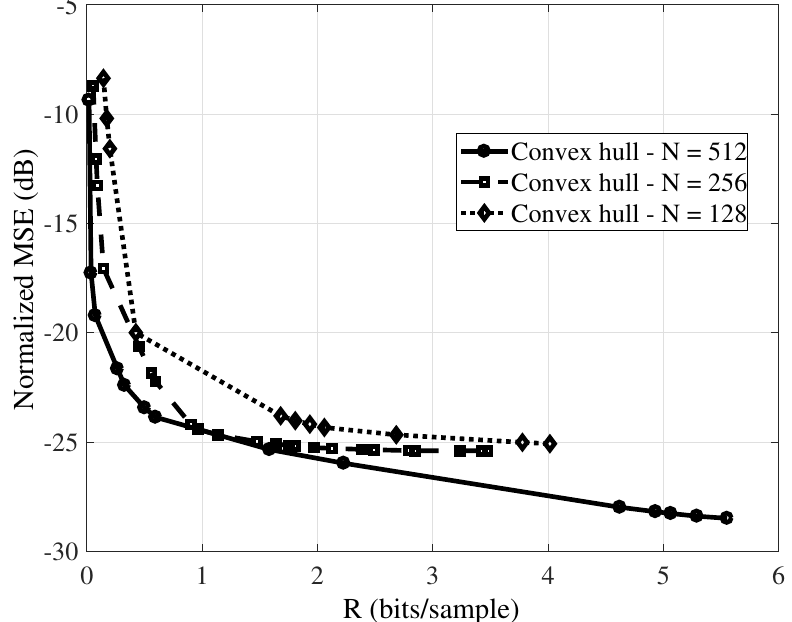
Figure 4. Rate-distortion convex hulls for the reconstruction of temperature signal with LASSO varying the length of monitored signal block ( N